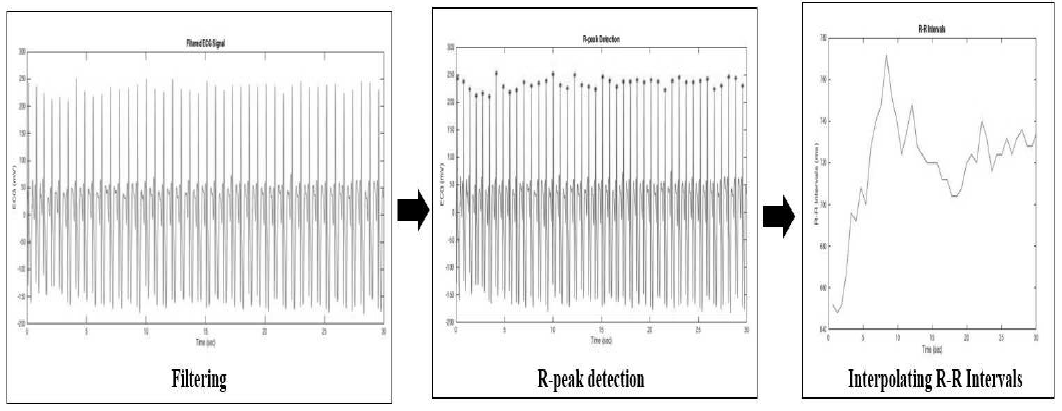
Figure 2. Example of pre-processing for first 30-seconds epoch from patient-1 with